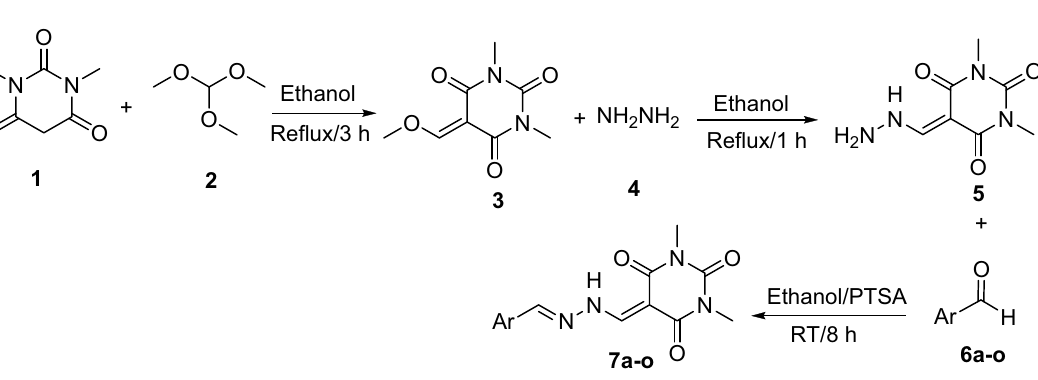
Figure 2. Synthesis of arylmethylene hydrazine-1,3-dimethylbarbituric derivatives 7a–o